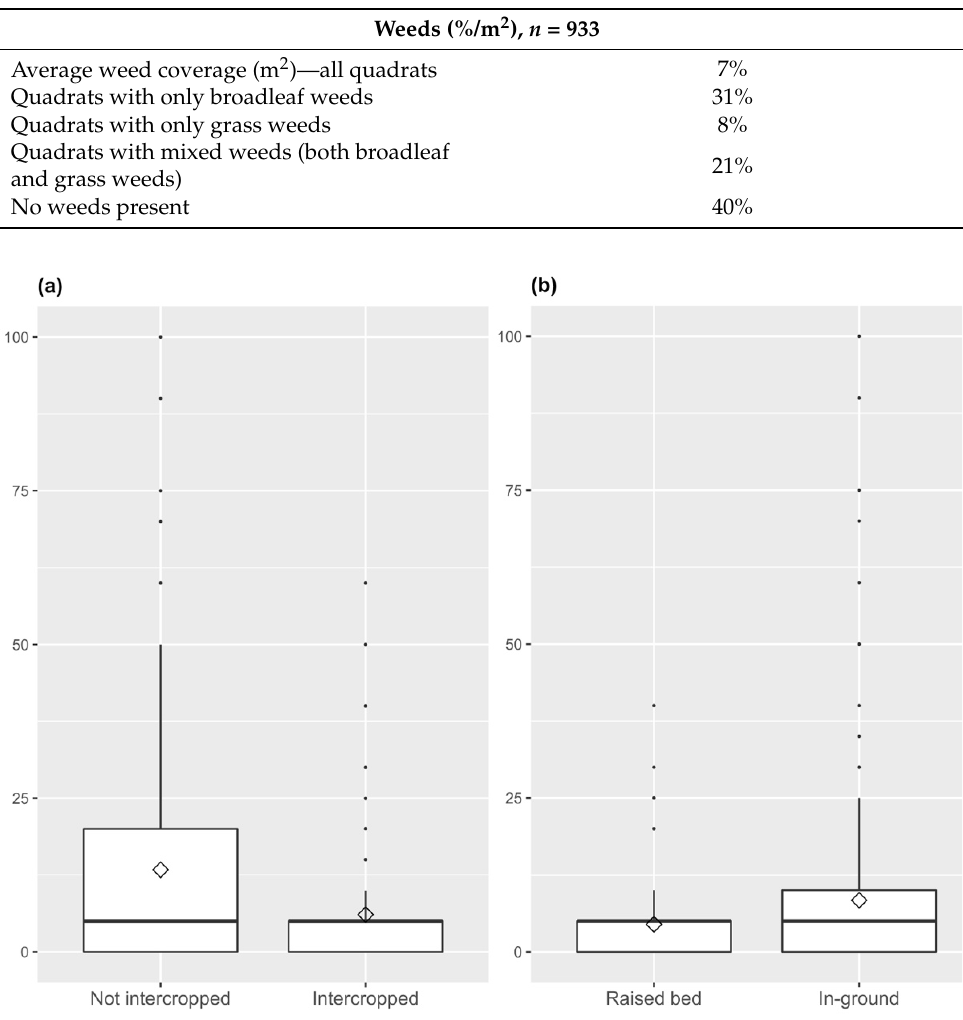
Figure 3. Percent coverage of weeds in intercropped beds and in-ground or bed production. ( a ) H(1) = 7.1671, p = 0.007; ( b ) H(1) = 30.434, p = 0.001.